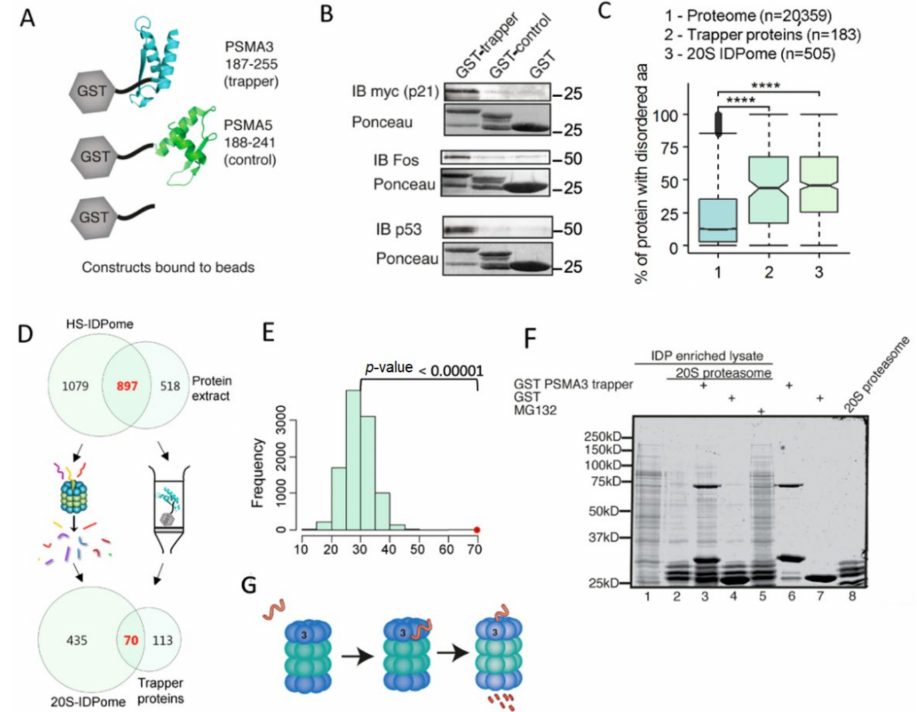
Figure 4. Isolated PSMA3 C-terminus interacts with many intrinsically disordered proteins. ( A )